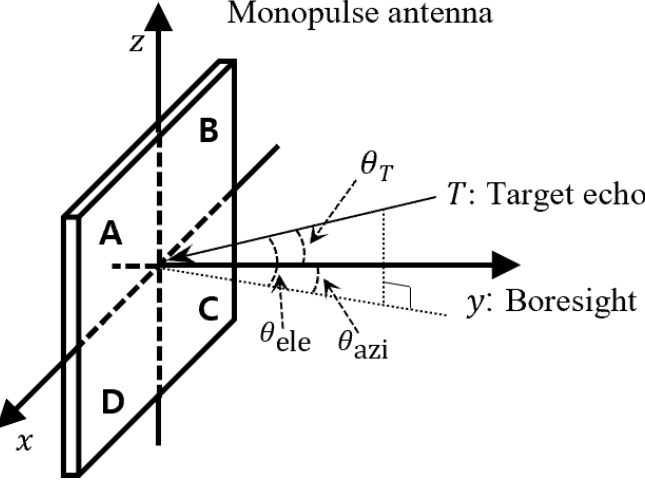
Figure 1. Monopulse antenna array and target angle